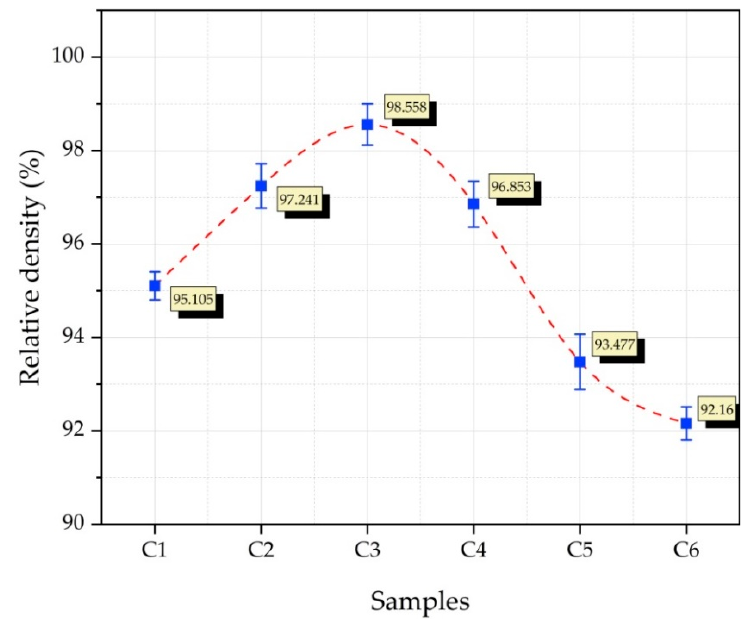
Figure 8. The composite samples’ relative density graph.